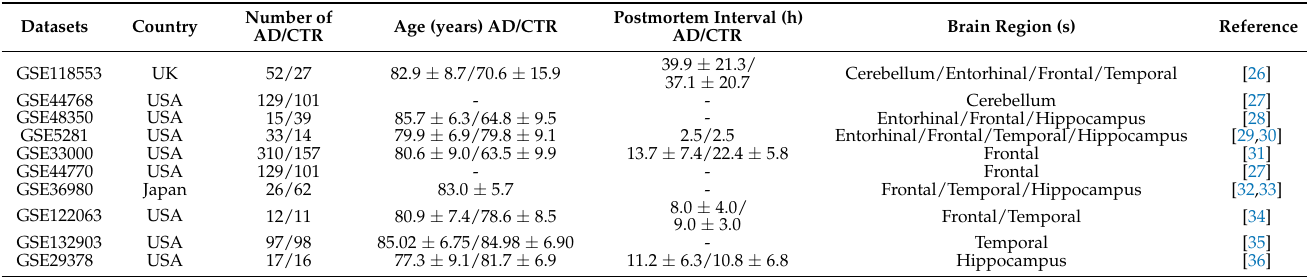
Table 1. Characteristics of the selected datasets based on the criteria of this study. Datasets